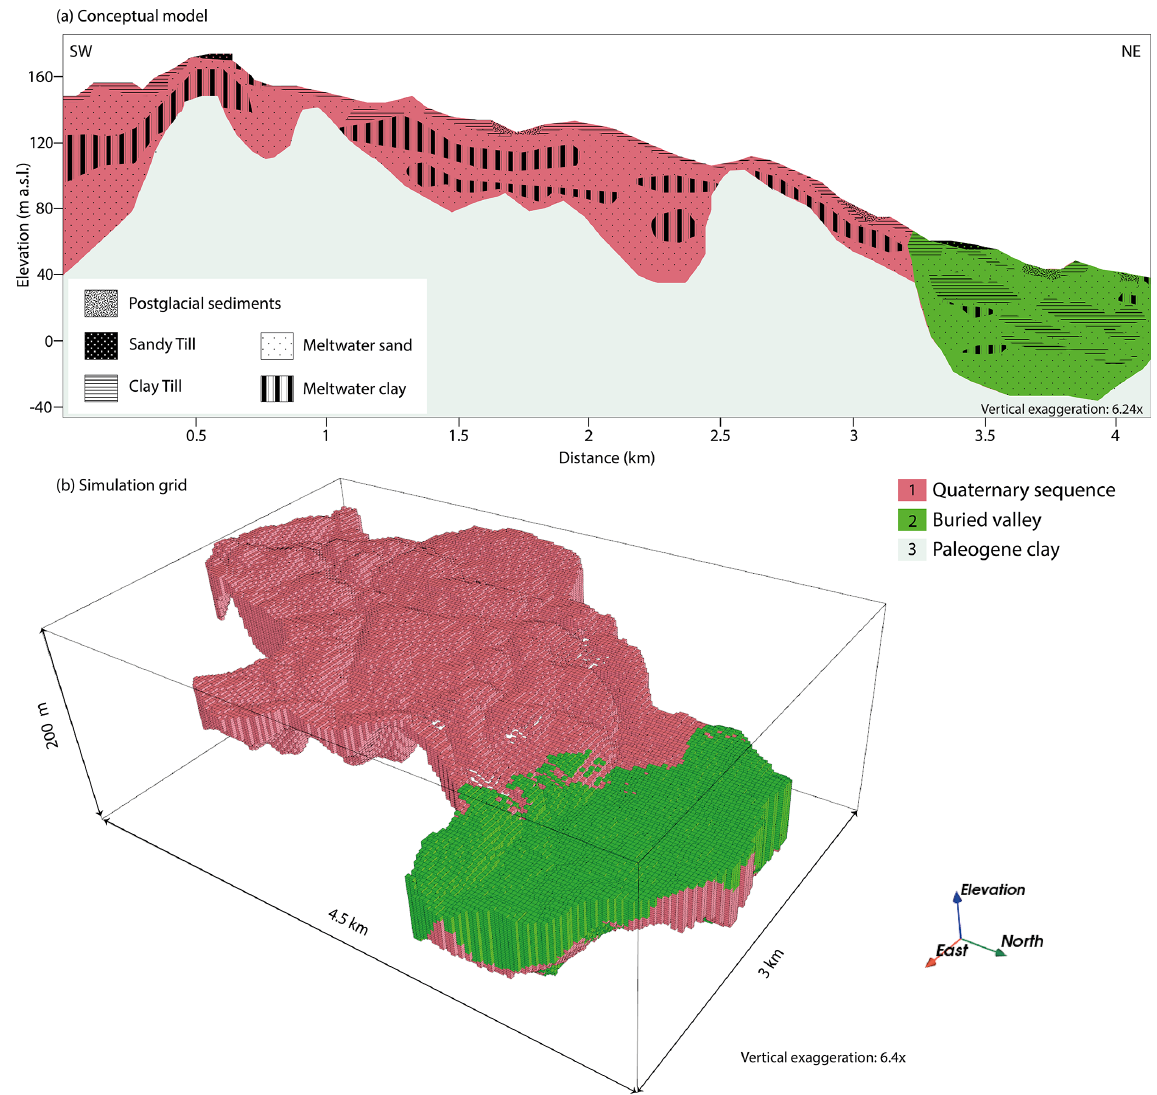
Figure 3. (a) Conceptual drawing of the SW/NE profile through the study area. (b) Simulation grid showing the two main geological elements used for the geostatistical